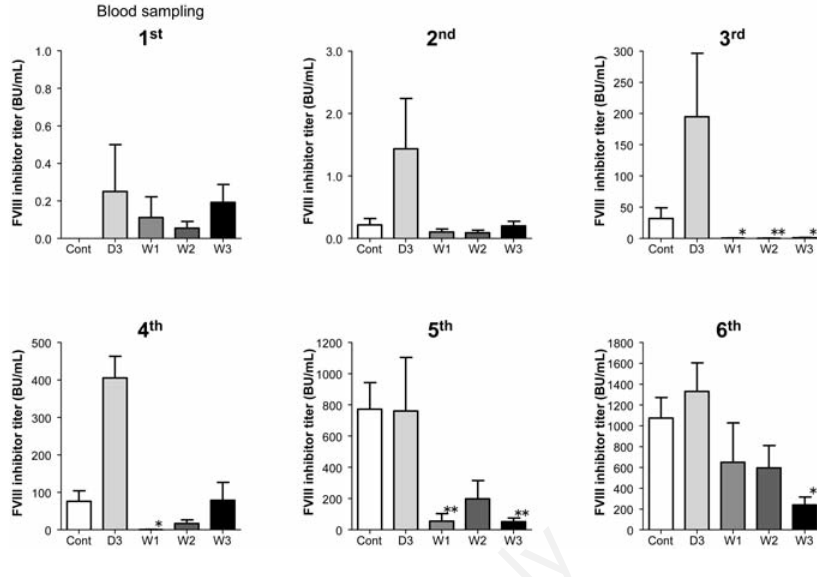
Figure 3. Effects of intraperitoneal injection of apoptotic factor VIII (fVIII)-expressing embryonic stem cells on fVIII inhibitor development. Intraperitoneal administrations of recombinant human fVIII (rhfVIII) for the induction of fVIII inhibitor development were started at 3 days, 1, 2, and 3 weeks after administration of the apoptotic cells (D3, W1, W2, and W3 groups, respectively) (n=4-8) and 1 week after administration of Ainv18 cells (Cont) (n=6). Data are presented as the mean ± standard error of the mean. *P<0.05, **P<0.01, compared with the control